Question: Name the type of graph shown.
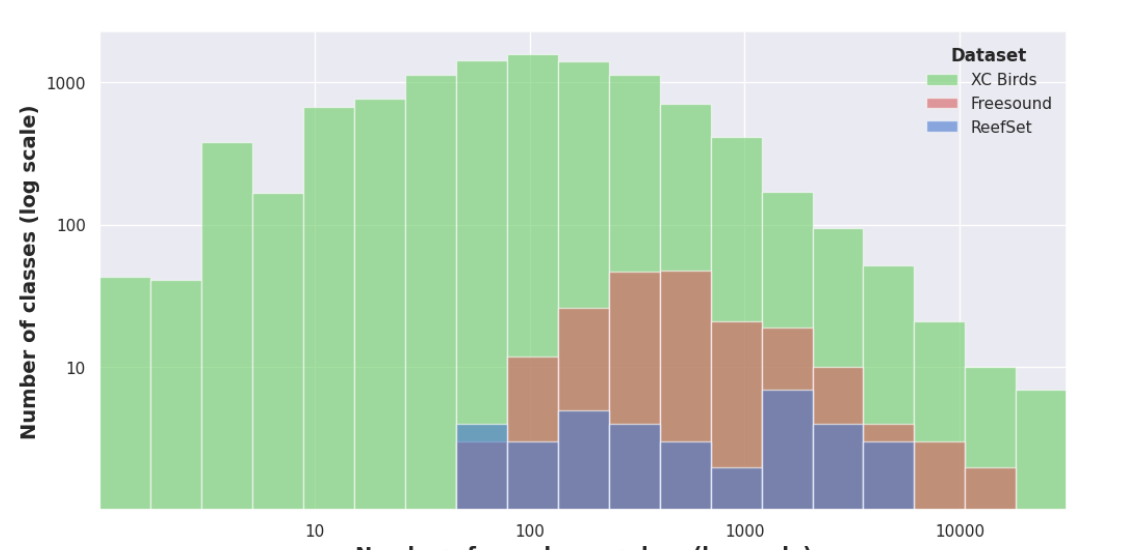
Answer: histogram